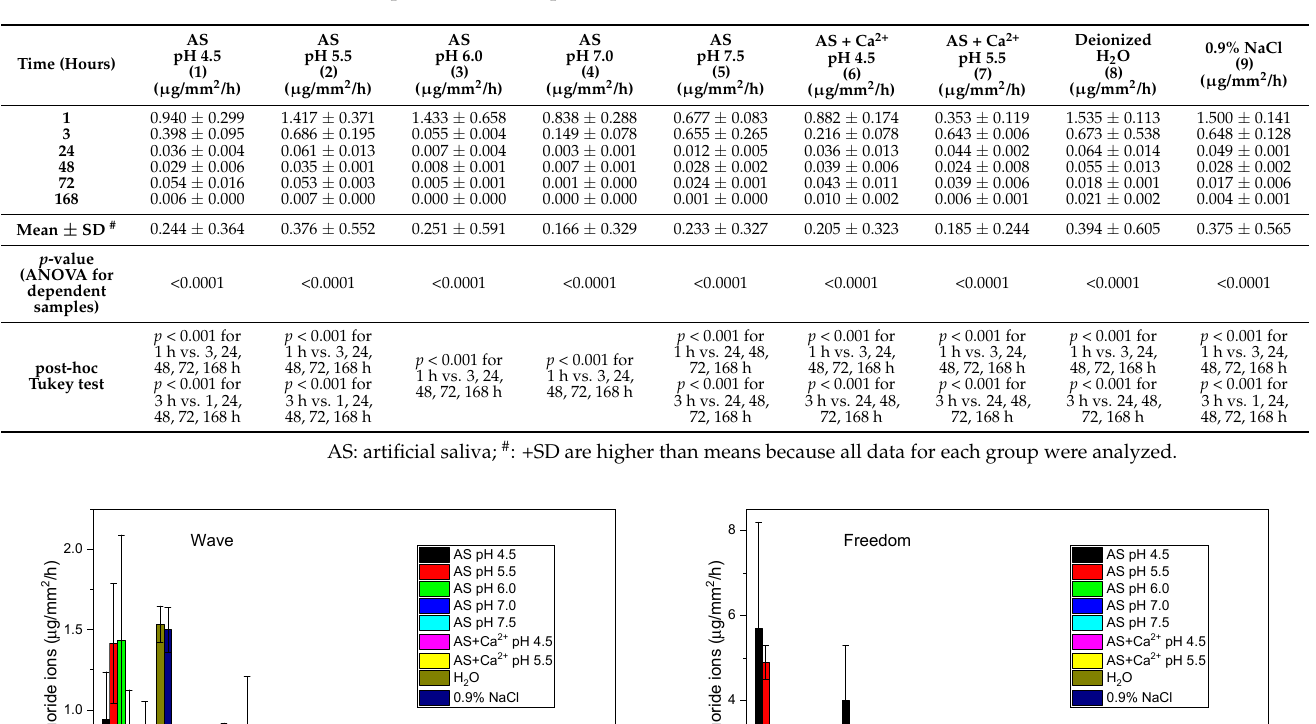
Table 1. Release of fluoride ions ( µ g/mm 2 /h) from composite Wave (W) into nine environments differing in composition of the solution and pH. Six samples were prepared for each solution. Descriptive data were presented as mean ± standard deviation ( ± SD).